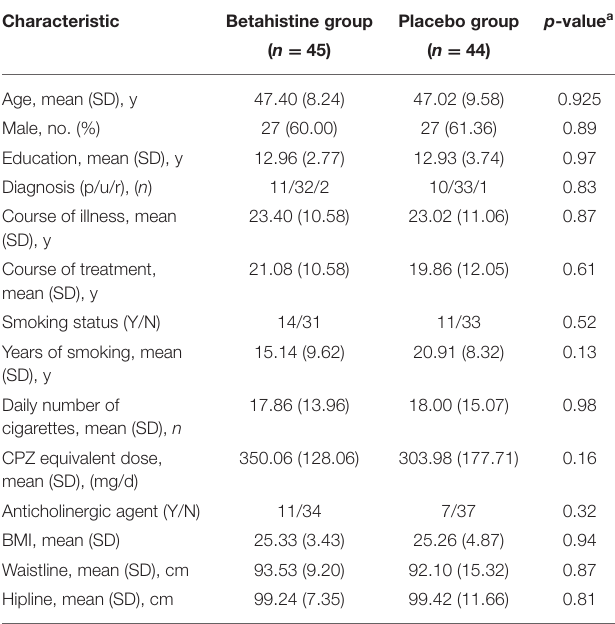
TABLE 1 | Baseline characteristics of participants by